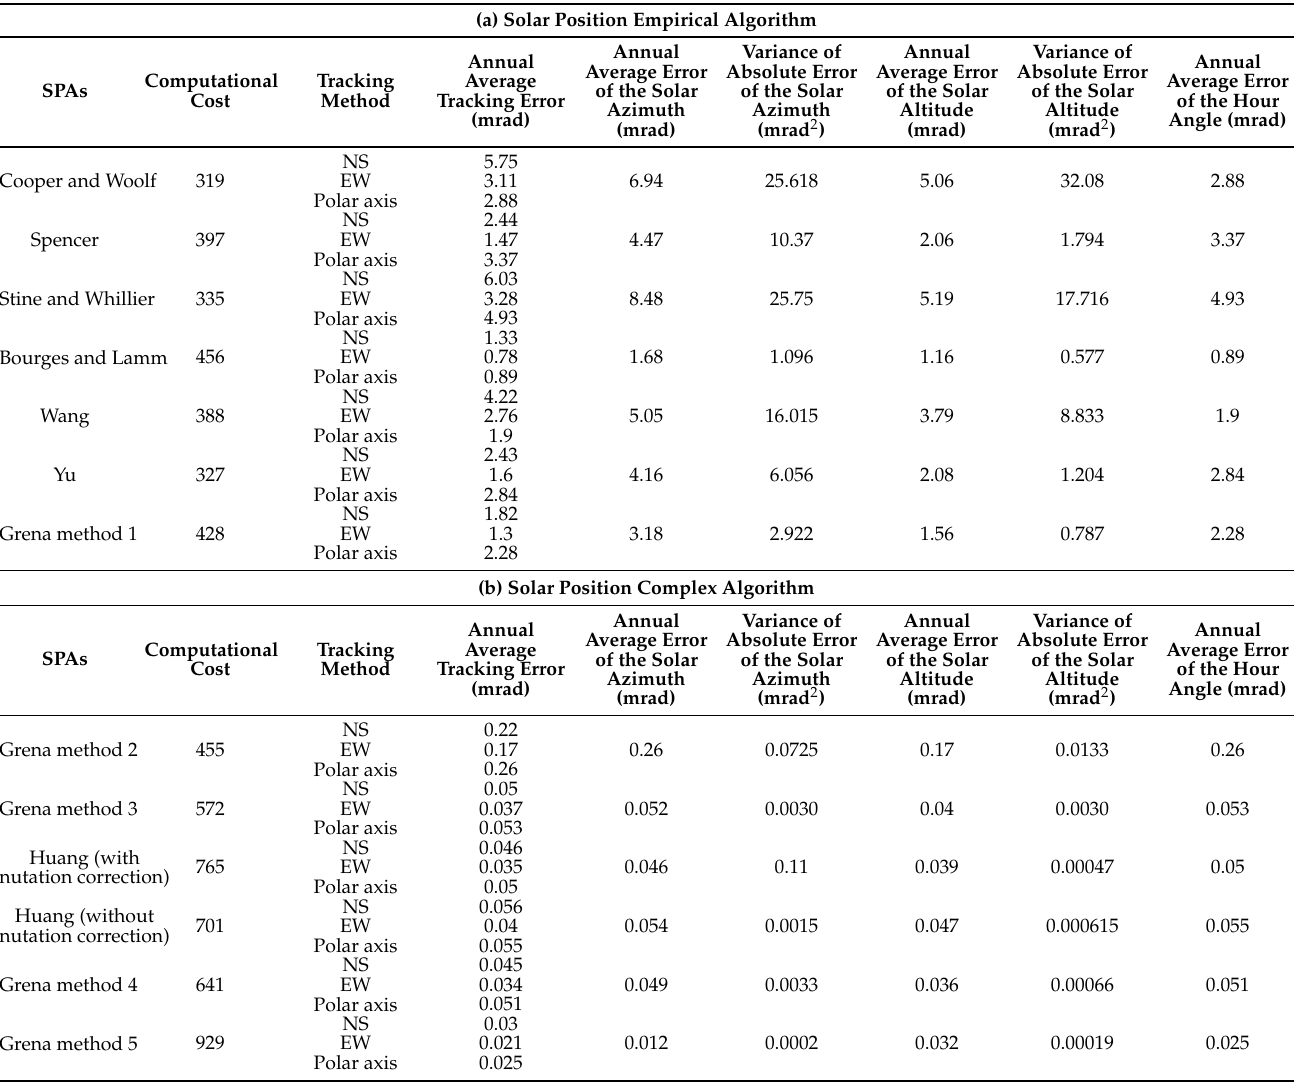
Table 2. The annual average tracking error and annual average error of the solar azimuth, solar altitude and variance thereof and hour angle of SPAs with different accuracy and computational cost values. NS: north–south axis tracking system, EW: east–west axis tracking system.